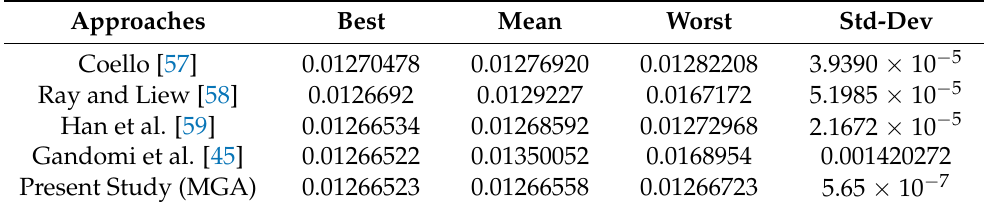
Table 9. Statistical results of different approaches for the tension or compression spring design problem.